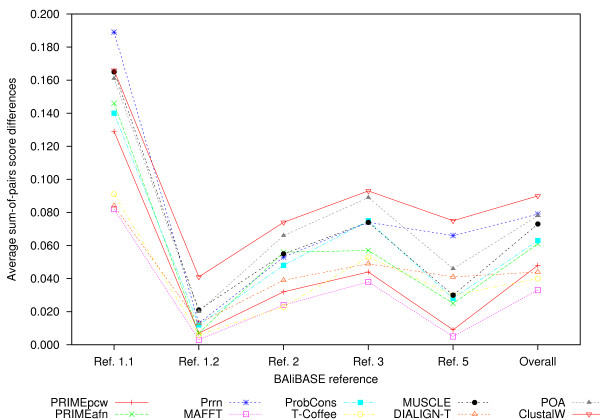
Average sum-of-pairs score differences between full length and homologous region sets. Each point means average sum-of-pairs score difference in respective alignments on each reference of the full length and homologous region sets. PRIMEpcw denotes PRIMEpiecewise, and PRIMEafn, PRIMEaffine. The smaller absolute value of a score indicates that the introduction of long terminal indels less affects the alignment accuracy of a program.